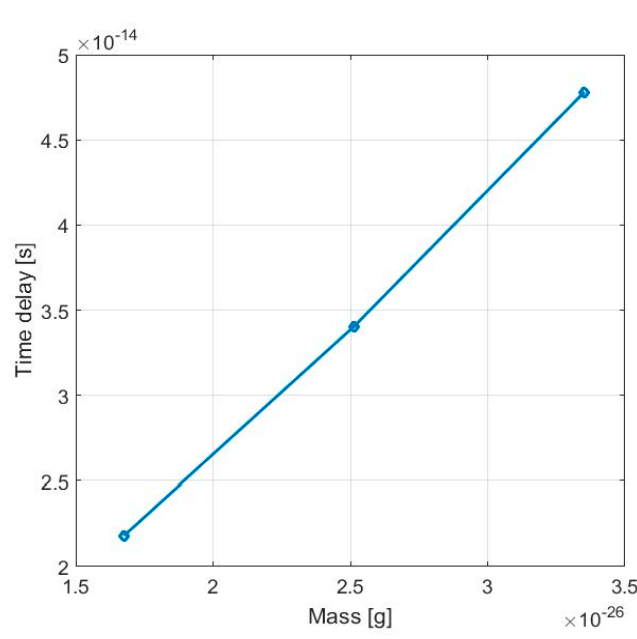
Figure 4. The mass sensitivity of the IIP/SAW